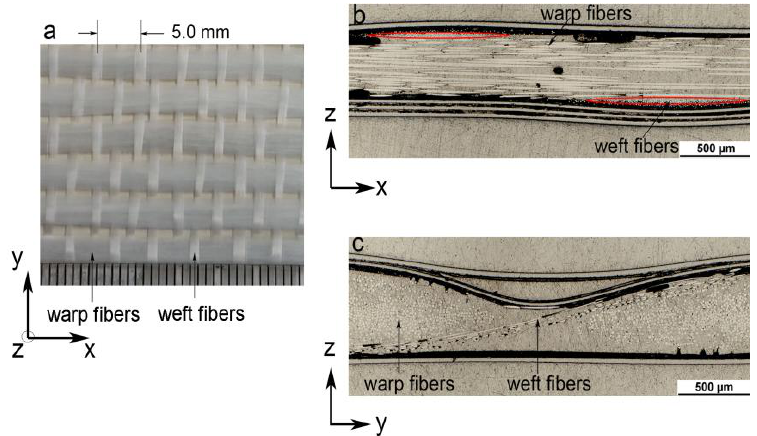
Figure 1. ( a ) Diagram of a quasi-UD woven fabric, observed on the top sight (z direction), ( b ) characteristics of the woven structure in the quasi-UD fabric in the weft direction, and ( c ) characteristics of the woven structure in the quasi-UD fabric in the warp direction.